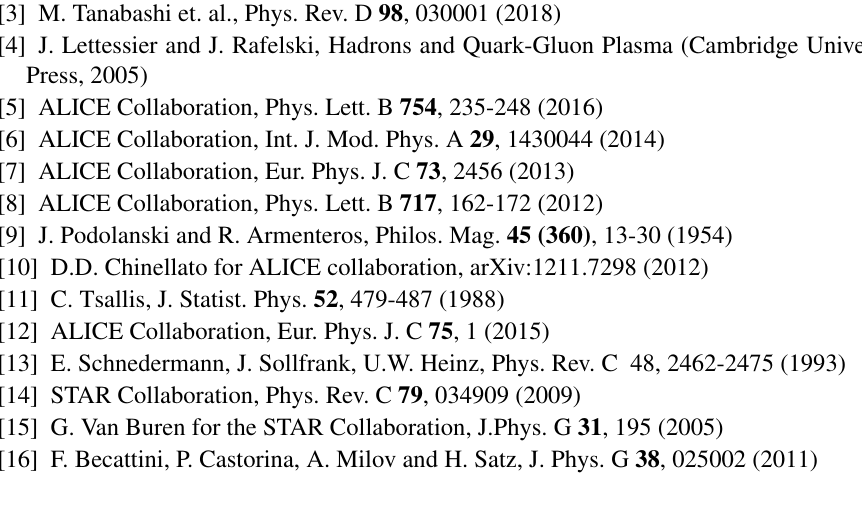
Figure 5. Energy dependence of the the integrated yield ratios Σ 0 + Σ taken from Ref.